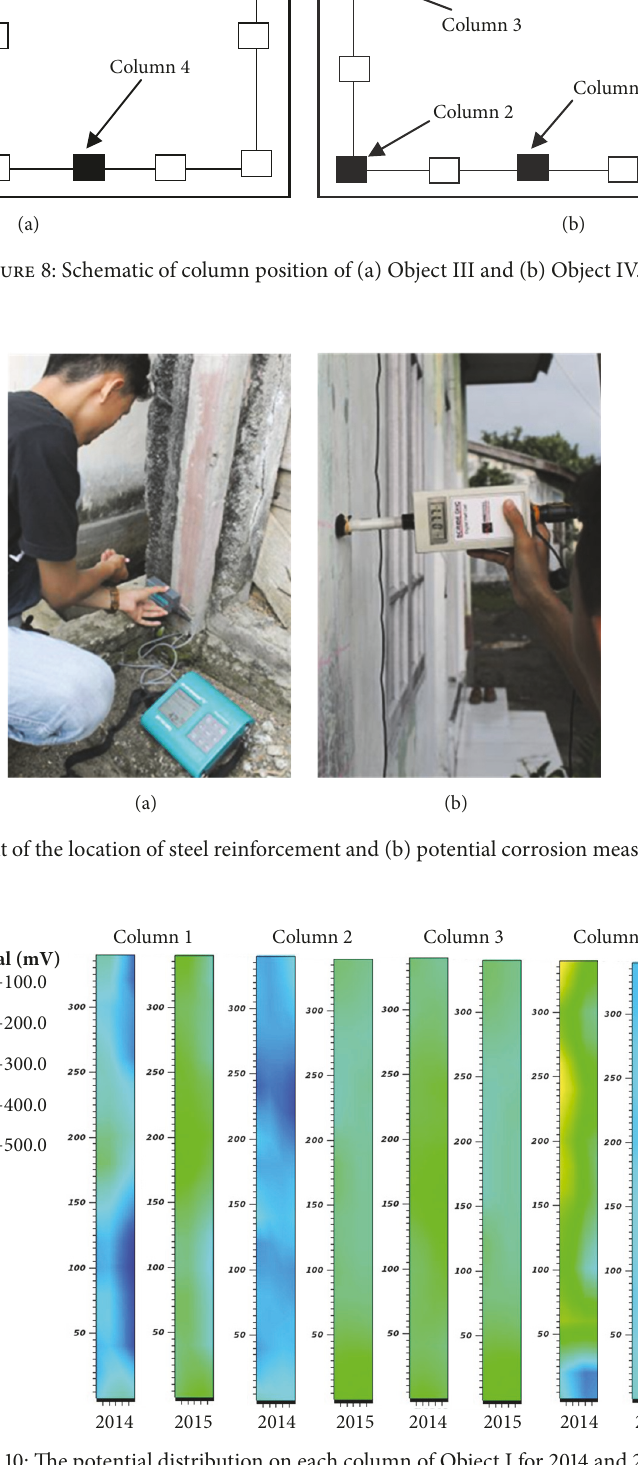
Figure 10: The potential distribution on each column of Object I for 2014 and